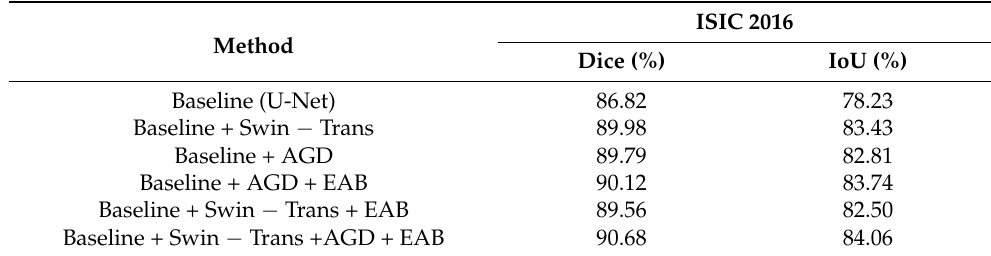
Table 2. Ablation experiments on ISIC 2016 dataset. Swin-Trans denotes the Swin Transformer block applied in prior attention network, AGD denotes the attention guiding decoder used for attention fusing, and EAB denotes enhanced attention block used for aggregation and